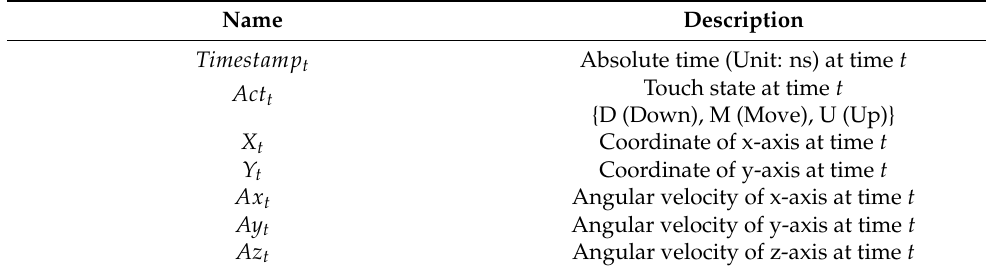
Table 3. Description of seven raw data variables.